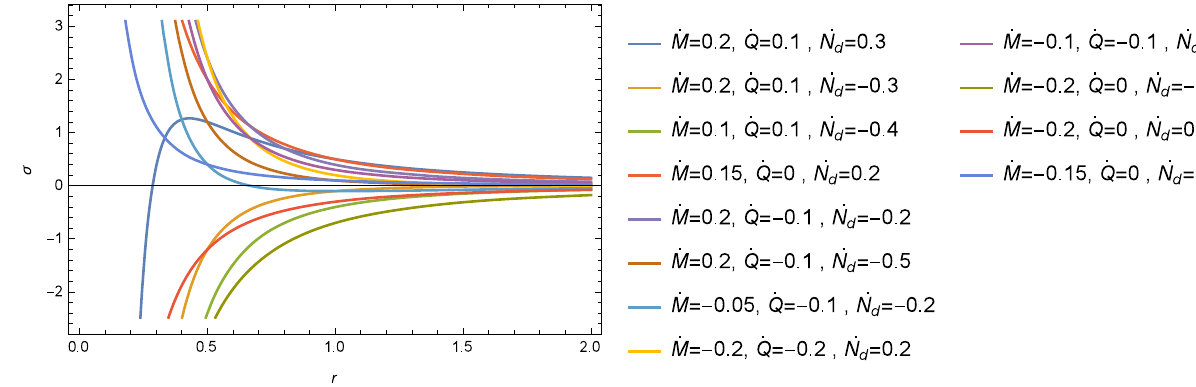
Fig. 2 Radiation-accretion density σ versus the distance r for some typical constant ˙ M , ˙ Q and ˙ N d values for (cid:2) = − 1 in the dust background. Here, we have set Q = 1 for simplicity